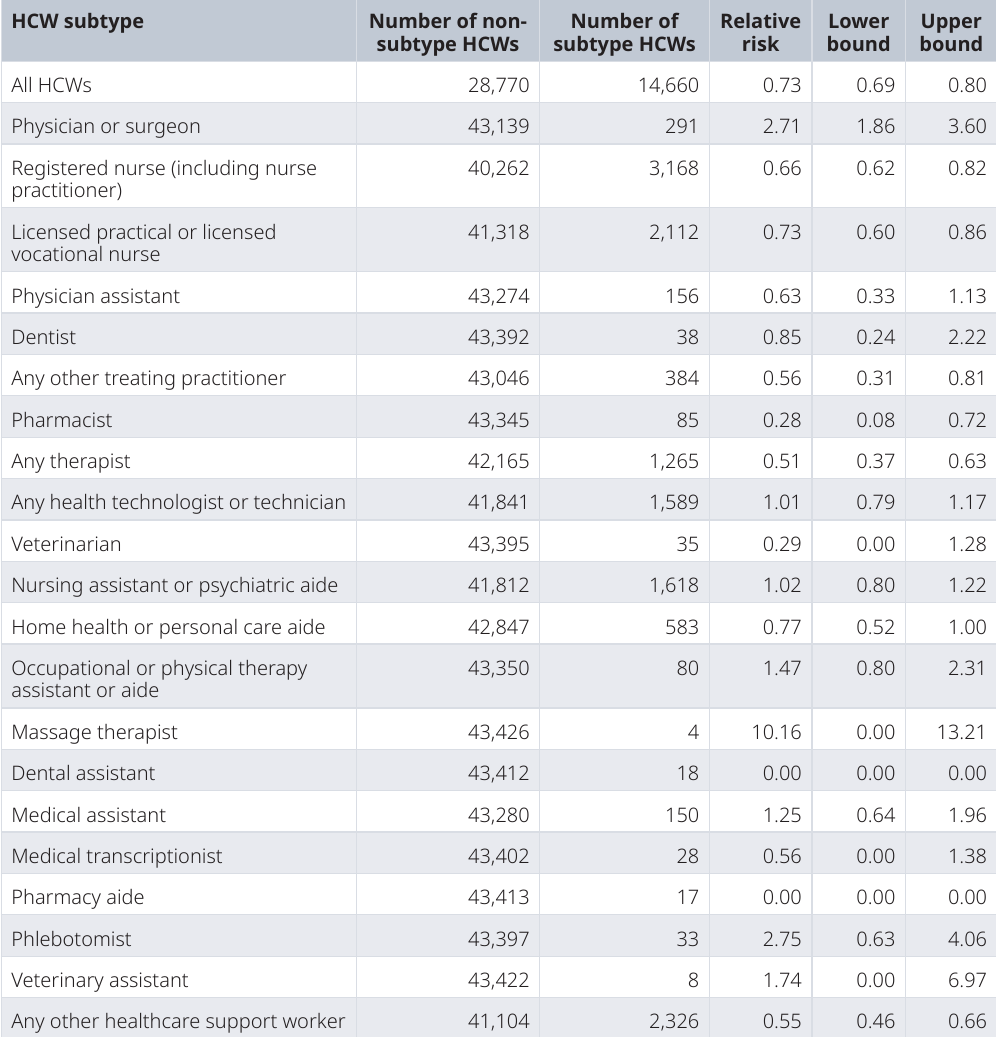
Table 3. Relative COVID-19 incidence rate (RR) and counts of healthcare workers (HCWs) and non- healthcare workers stratified by worker